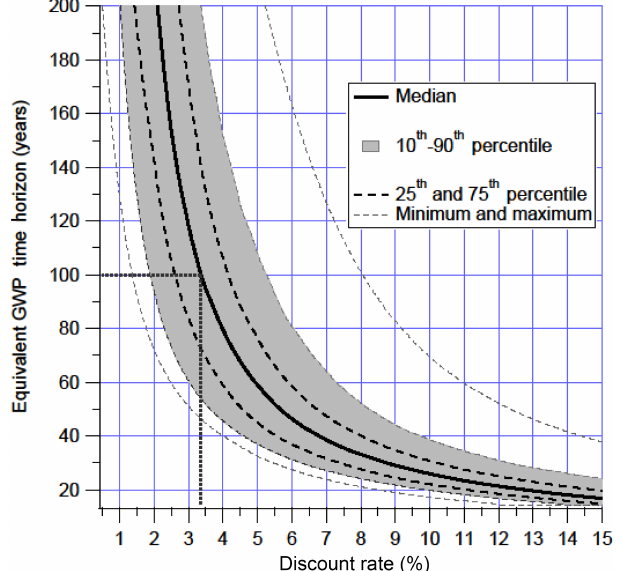
Figure 1. Impacts of emission pulses of CH 4 and CO 2 . Radia- tive forcing (a) , temperature (b) , damages (c) , and discounted dam- ages (3%, a ) for an emission pulse of 28.3MT CH 4 (10ppb in the first year) and 24.8 times as much CO 2 emissions by mass. The un- derlying scenario is RCP6.0, with other parameters at their central values.